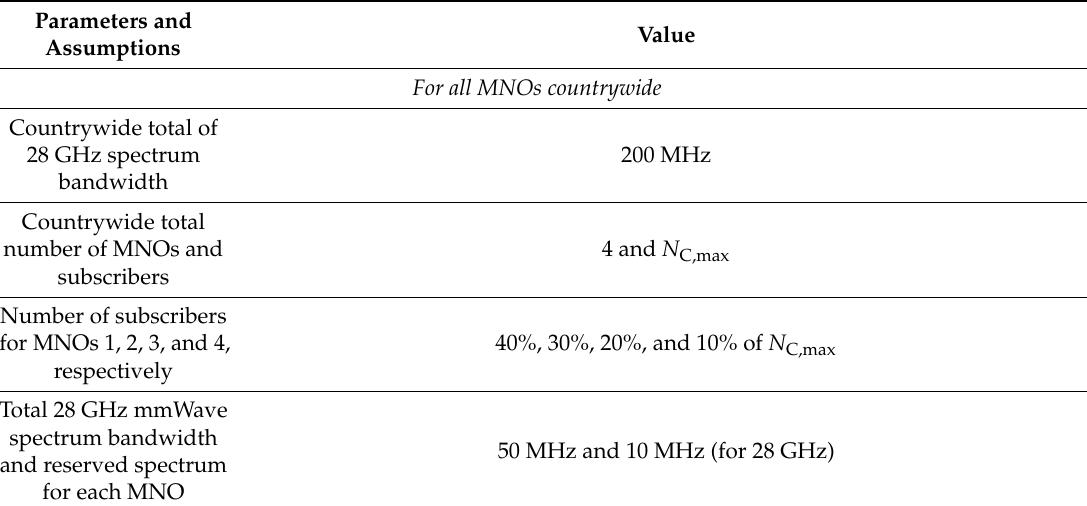
Table 1. Default parameters and